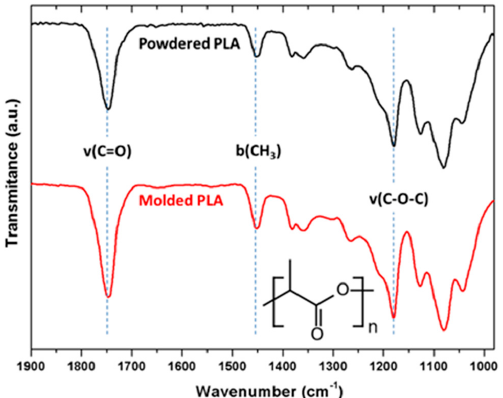
Figure 3. FTIR spectrum of polylactide (PLA ) efore (black) and after (red) being molded.